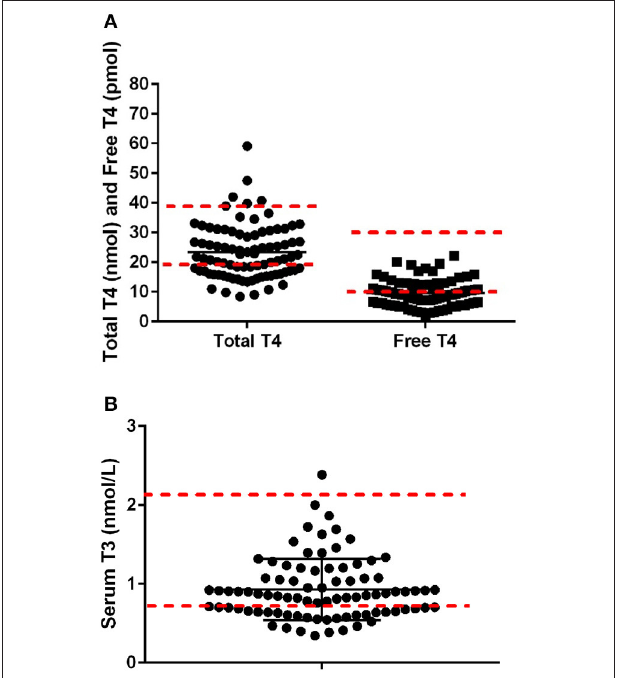
FIGURE 1 | (A) Serum concentrations of total thyroid hormone concentration (range 18–38 nmol/L) and free thyroid hormone (range 8–28 nmol/L; n- − 86) in Alaskan Huskies. (B) Serum concentrations of T3 hormone concentration (range 0.8–2.1 nmol/L; n- − 86) in aging Alaskan Huskies. Red dashed lines are the lower higher reference range based on Cornell University Diagnostic Laboratory Endocrinology